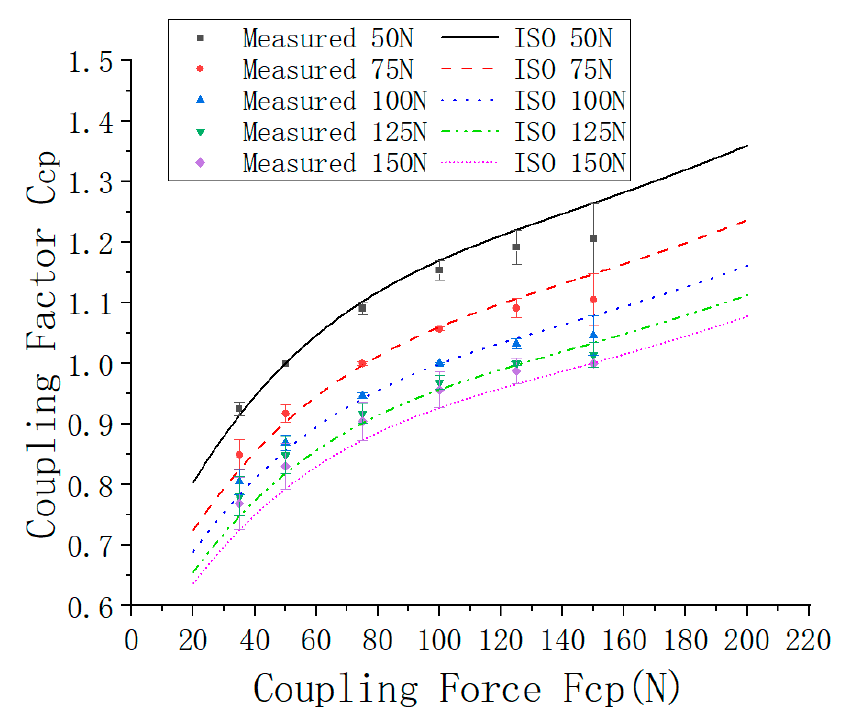
Figure 7. Overall measured coupling factors and comparison with the recommended curves in ISO TS 15230-2